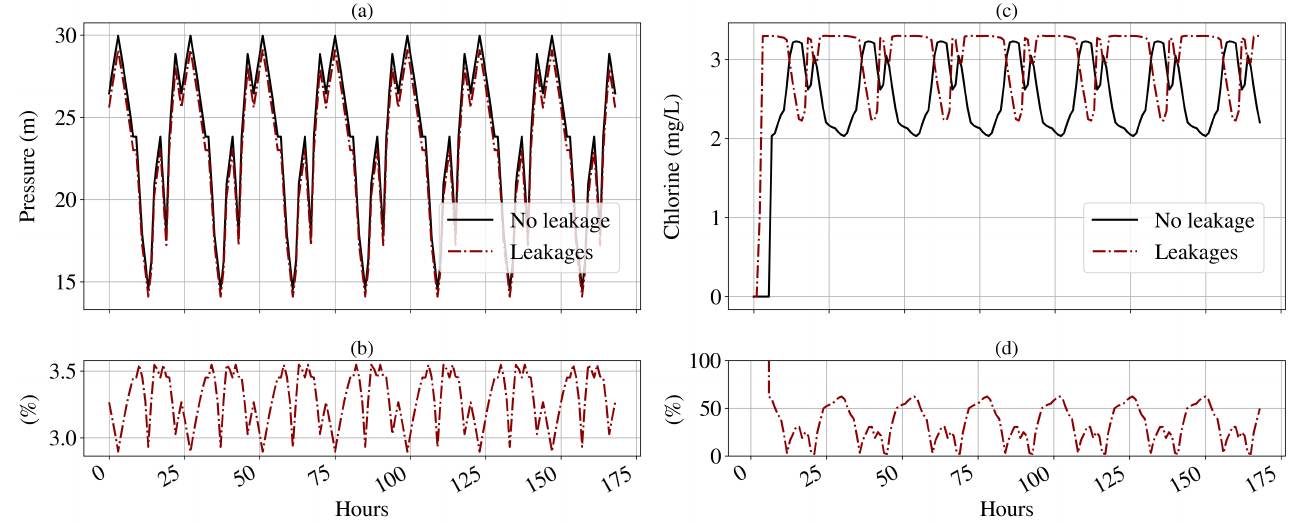
Figure 8. Pressure and chlorine behavior at note 104 with leakage at node 37: ( a ) Pressure variation,